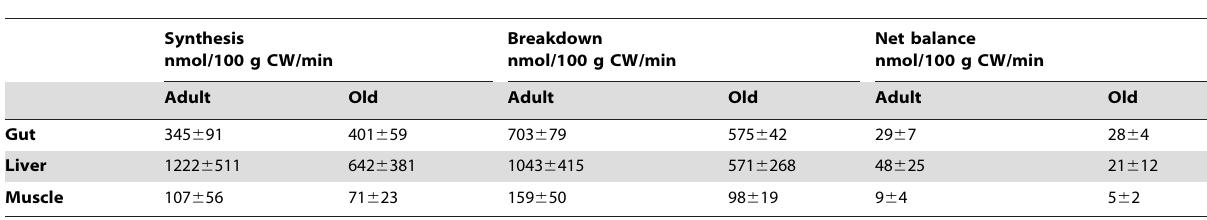
Table 5. Effect of aging on organ protein kinetics at the fed state.